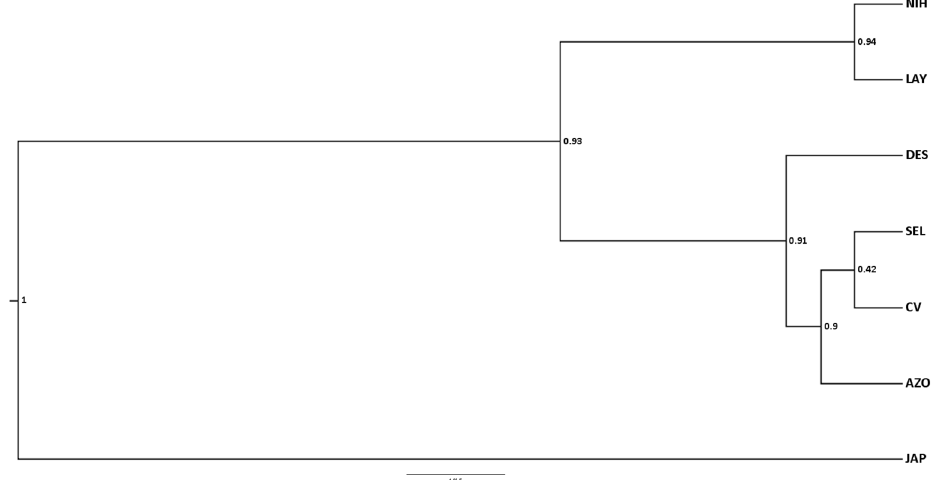
Figure 3. Species tree phylogeny. Phylogeny of the different populations sampled reconstructed with a combined dataset of a mitochondrial locus (NADH2) and thirteen nuclear anonymous markers with BEAST v1.7 (http:// beast. commu nity/ index. html) and visualized with FigTree v.1.3.1 (http:// tree. bio. ed. ac. uk/ softw are/ figtr ee/). Nodal support is indicated by Bayesian posterior probabilities. Bar is in substitutions/site.